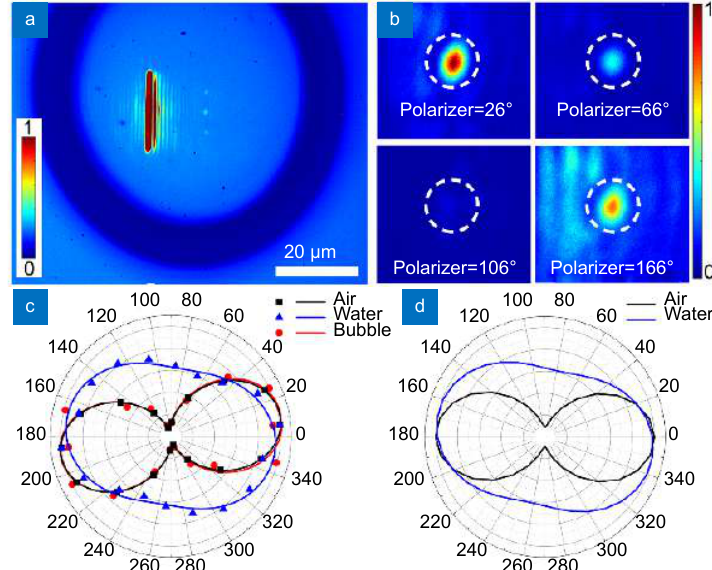
Fig. 6 | ( a ) CMOS image of a microbubble, which covers the sample. ( b ) CMOS images of the emission light from the plasmonic emitter in the mi- crobubble at different polarizer angles. ( c ) Polar plot of the measured intensities of the emission light from the plasmonic emitter by rotating the polarizer in air (black), water (blue), and bubble (red). ( d ) Polar plot of the simulated intensities of the emission light from the plasmonic emitter at different polarizer angles when the plasmonic emitter is covered by air (black), water (blue), and bubble (red). The result in air is the same as that in the bubble, so the red line is covered by the black